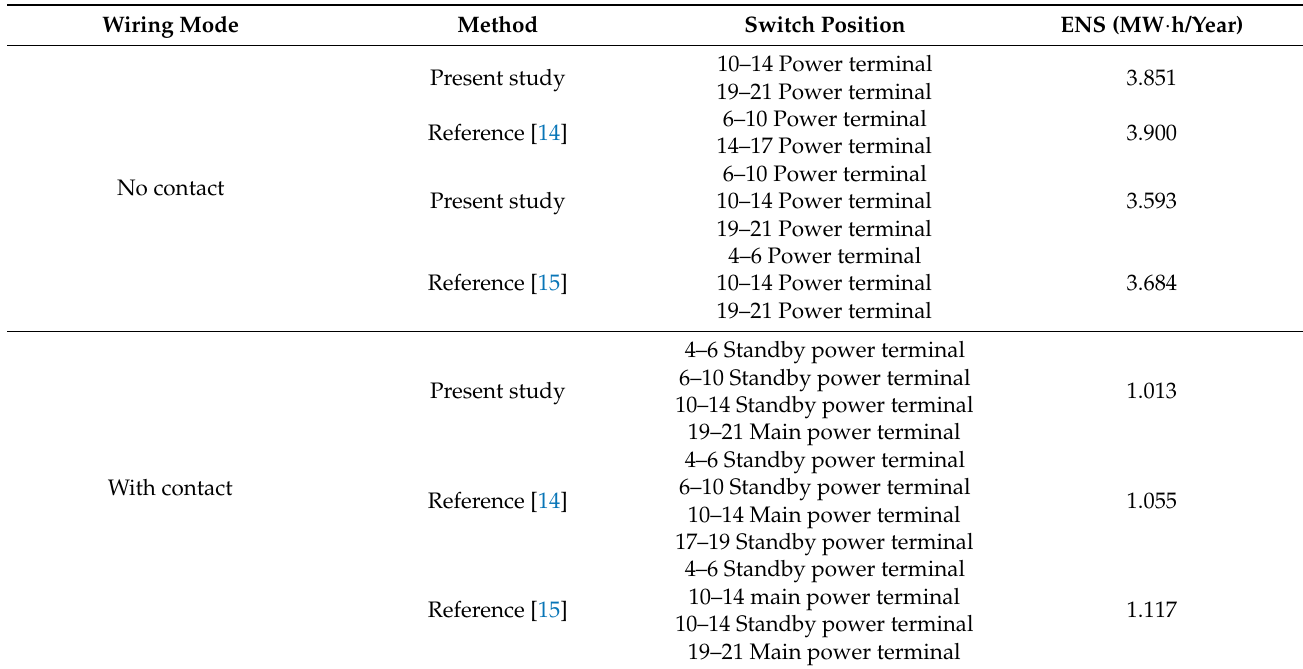
Table 2. Example 1: comparison of the switch position-optimisation result.